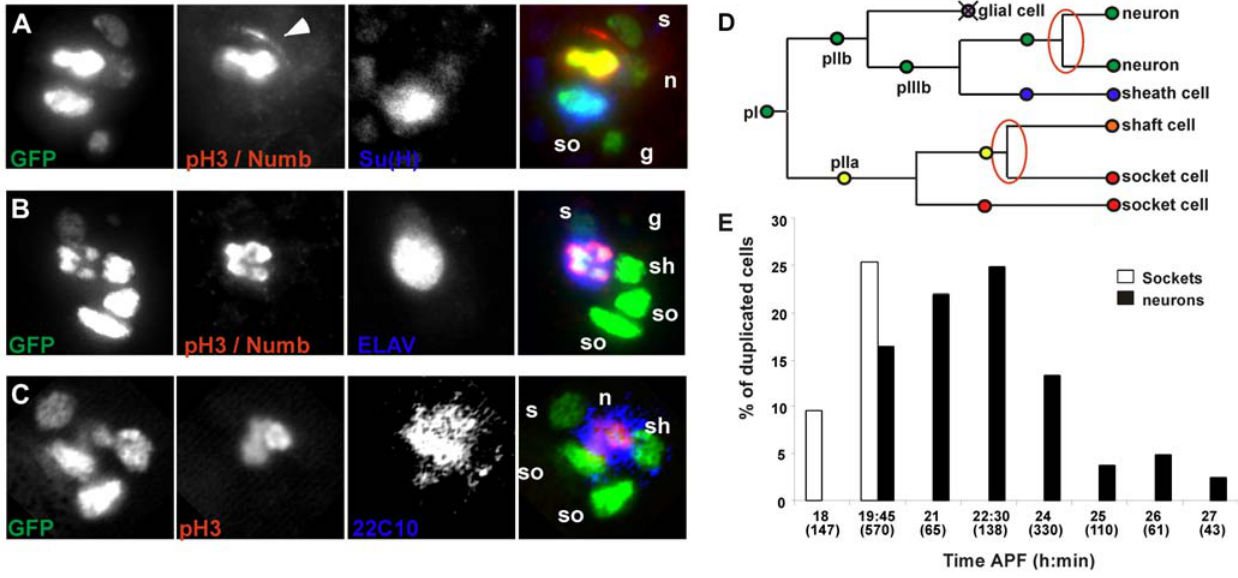
Figure 3. Extra mitoses occurred in the future shaft cells and neurons. (A–C) Mitoses are revealed by PH3 immunoreactivity (second columns and red in the super-imposed images, right panels); in the same panels, Numb immunoreactivity (arrowhead in the second column, red in the merge). PH3 and Numb are fully distinguishable by their respective nuclear and cortical locations. Socket cells and neurons are respectively identified using Su(H) and ELAV or 22C10 immunoreactivity (blue). Sensory cells are detected by their GFP immunoreactivity. (A) neur . CycE , H2B::YFP pupae at 21– 22 h APF. An extra mitosis occurs in the future shaft cell, which is identified by nuclear size and lack of Su(H) accumulation. n: neuron; s: sheath cell; sh: shaft cell; so: socket cell; g: glial cell. (B) neur . CycE , H2B::YFP pupae at 24–25 h APF. Extra mitosis (red in the right panel) occurring in an ELAV positive cell (blue). (C) neur . CycE , H2B::YFP pupae at 24–25 h APF. Extra mitosis (red in the right panel) in differentiated neurons identified by the presence of the late neuronal-specific marker 22C10 (blue in the right panel). (D) Schematic representation of the bristle lineage after CycE overexpression. Extra mitoses are encircled in red. (E) Histogram showing the percentage of duplicated socket cells (white bars) and neurons (black bars) obtained after CycE overexpression induced by a heat shock applied between 18 h and 27 h